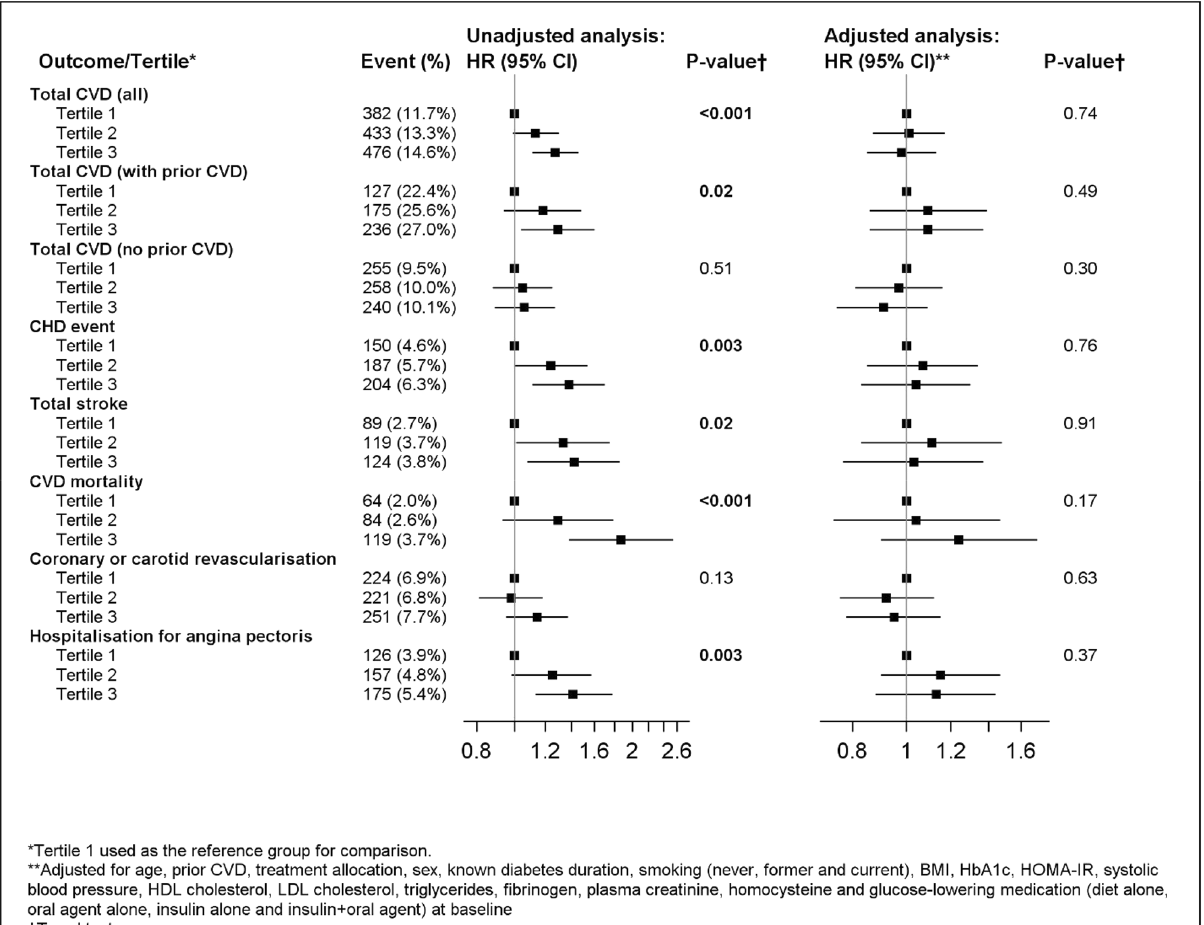
Figure 1. Association of baseline LMW-F levels with on-study CVD events over 5